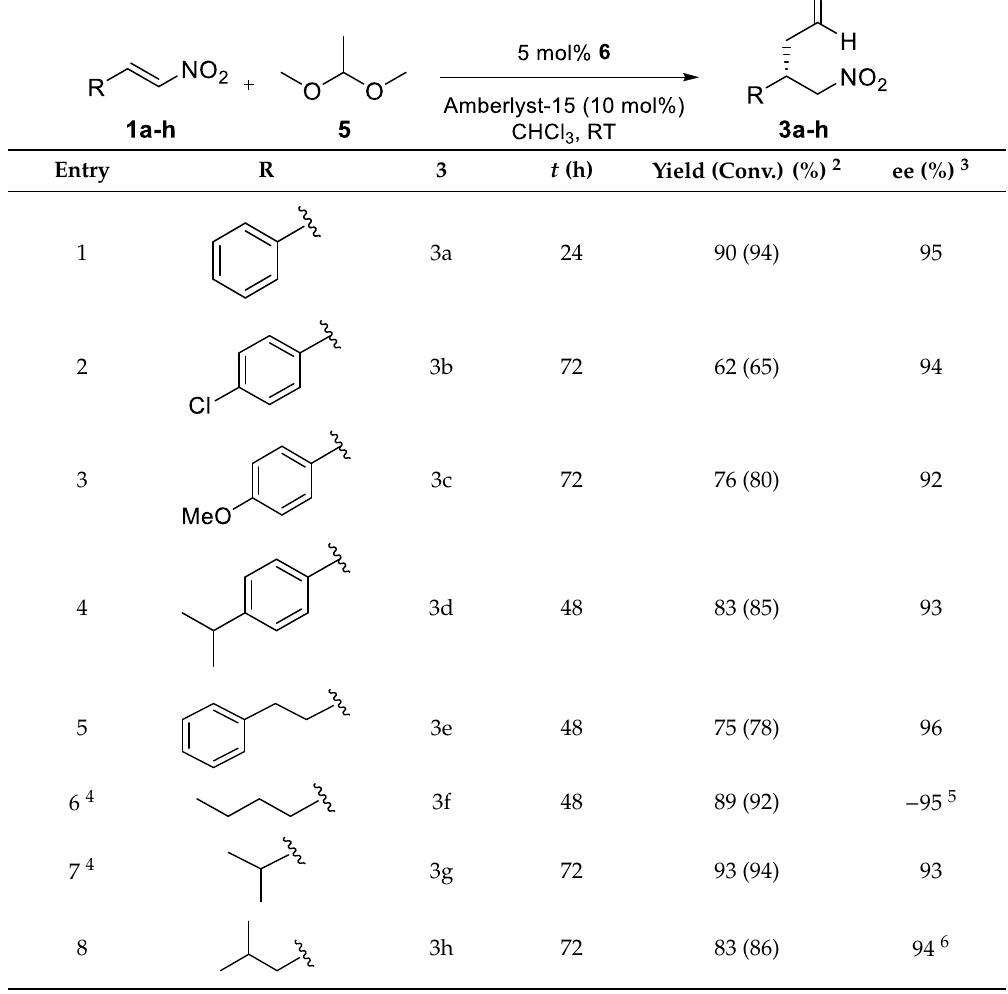
Table 3. Catalytic Michael addition of acetaldehyde dimethyl acetal 5 with various nitroalkenes 1 .